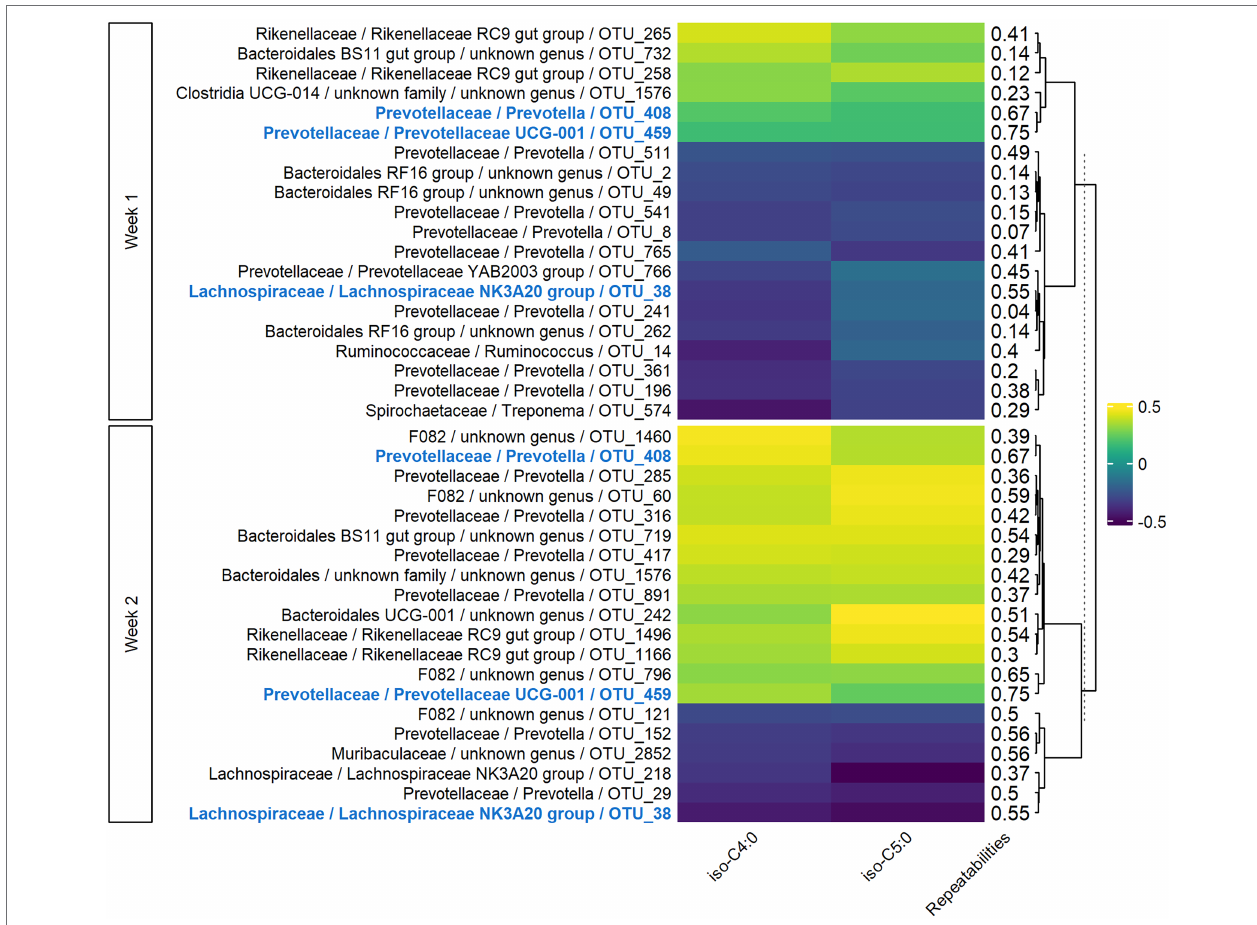
FIGURE 3 | Pearson correlations between bacterial OTUs and VFAs on both weeks of sampling. Only the 20 more correlated OTUs and VFAs having at least one significant correlation in both weeks with them were presented. In bold and blue, OTUs conserved from week 1 to week